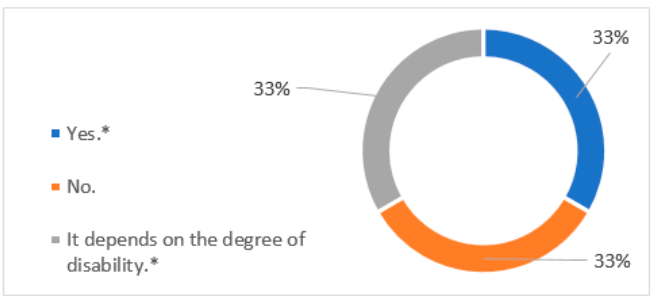
Figure 3. Do people with disabilities have any special circumstances with respect to other workers, for example, a shorter working day or different contracts?